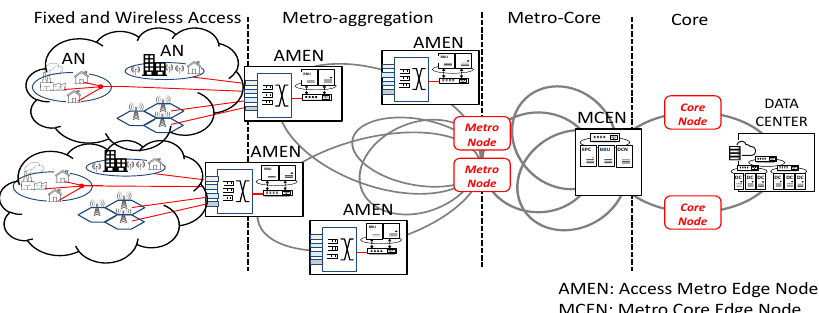
Figure 1. Network topology considered in our